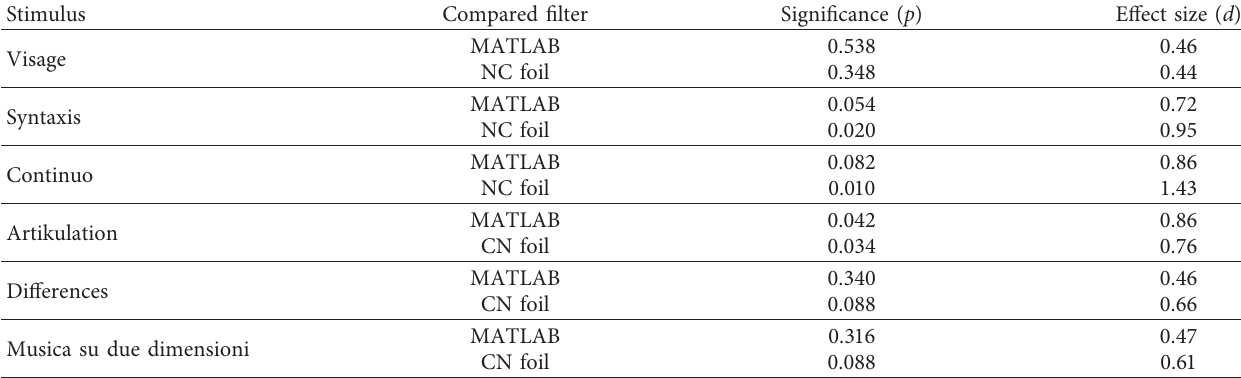
Table 6: Results of paired sample t -tests between the Hidden reference and the remaining filters by stimulus. Bonferroni correction has been applied to p values. Effect size refers to Cohen’s d .